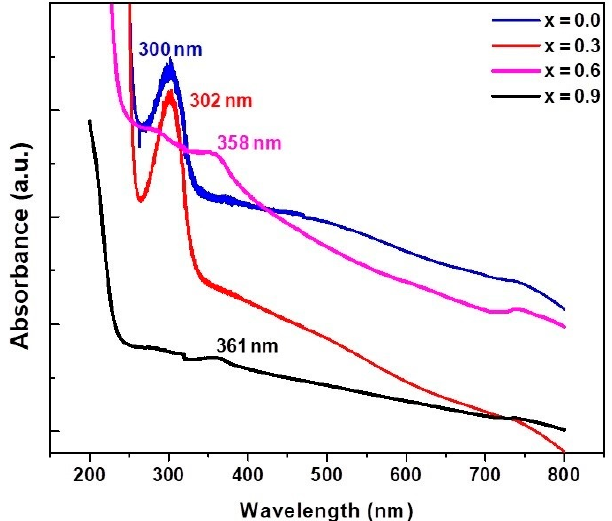
Figure 7. UV–visible spectra copper ‐ substituted, plant ‐ extracted cobalt ferrite nanoparticles Co 1 − x Cu x Fe 2 O 4 (0 ≤ x ≤ 1): at x = 0.0; pure CoFe 2 O 4 , at x = 0.3; Co 0.7 Cu 0.3 Fe 2 O 4 , at x = 0.6; Co 0.4 Cu 0.6 Fe 2 O 4 and at x = 0.9; Co 0.1 Cu 0.9 Fe 2 O 4 .